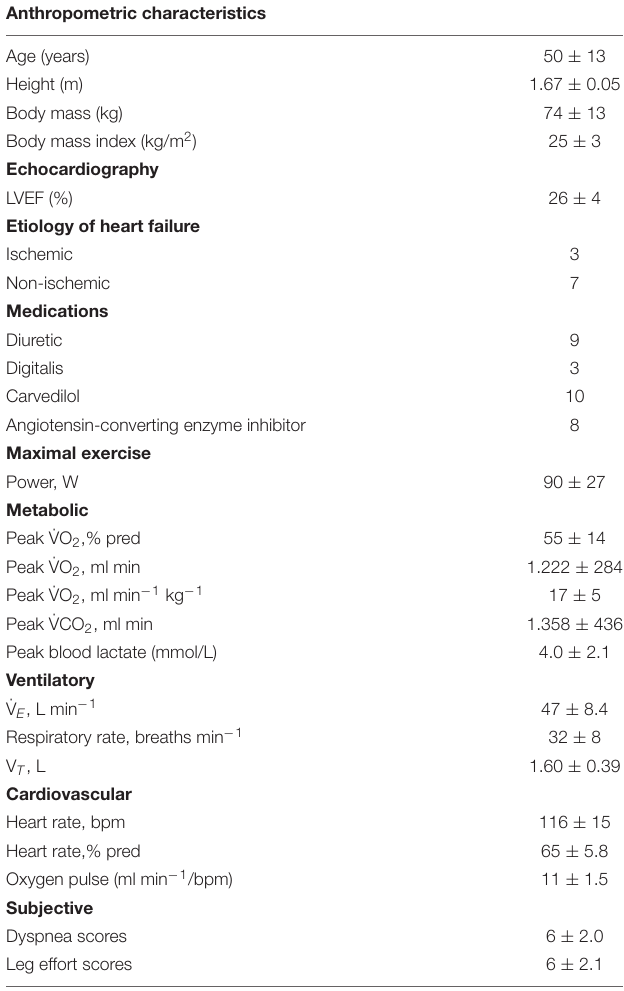
TABLE 1 | Patient characteristics at rest, medication used, and cardiopulmonary exercise testing data ( N =